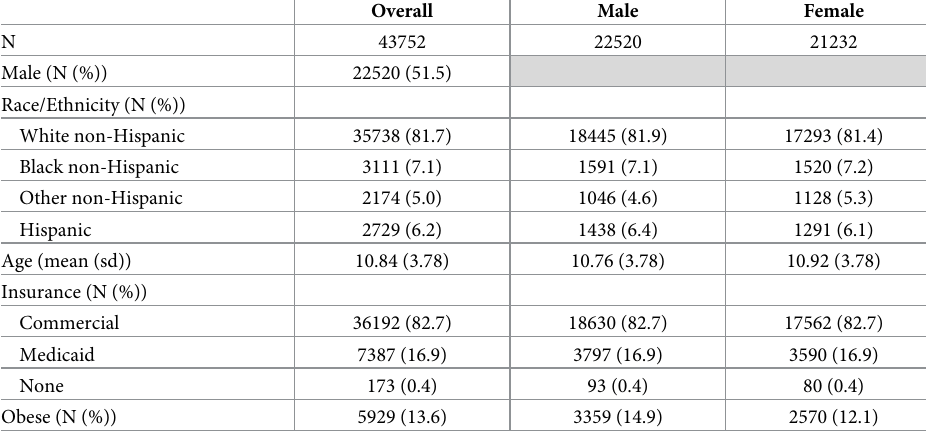
Table 1. Demographics in UW Public Health Information Exchange